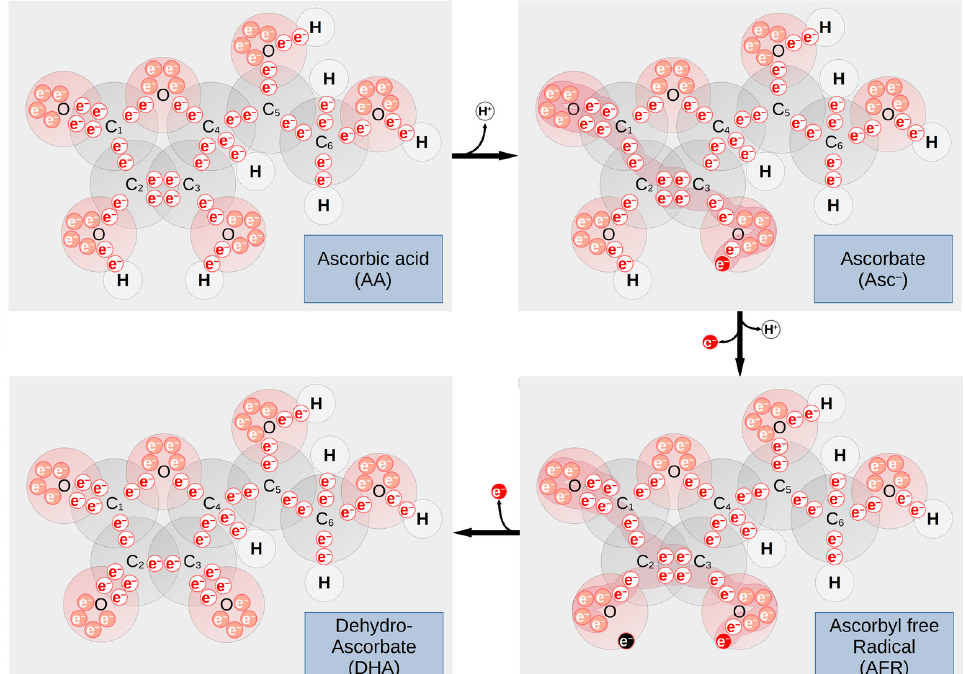
Figure 3. Overview of vitamin C chemistry. Due to its acidic properties, the majority of ascorbic acid is transformed into ascorbate by losing a proton in the C3-position under physiological conditions. Negative charge can be translocated among the molecule, stabilizing the ascorbate anion (the area of electron delocalization additionally marked in red color). The reducing agent ascorbate can be oxidized (e.g., by cellular NAD + or metal ions in the plasma) resulting in the reactive intermediate AFR after losing one proton and one electron (the area of electron delocalization additionally marked in red color). AFR is further oxidized to the more stable DHA by losing another electron. The figure shows all the valence electrons of the oxygen atoms as small circles labeled with e − . Most important electrons for the presented reactions are highlighted in red color, while the unpaired electron of the free radical is marked black. Atomic radii of the elements are drawn in size ratio. For simplicity, data of the covalent radii for single bonds were used (H = 32 pm, C = 75 pm, O = 63 pm). AA—ascorbic